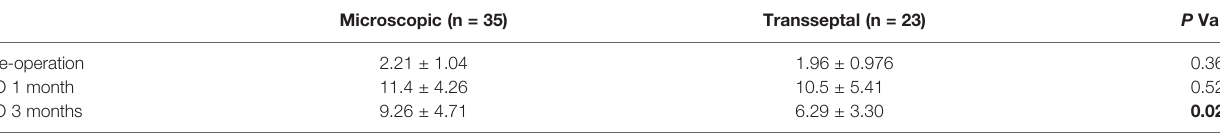
TABLE 4 | Anterior skull base nasal inventory survey.